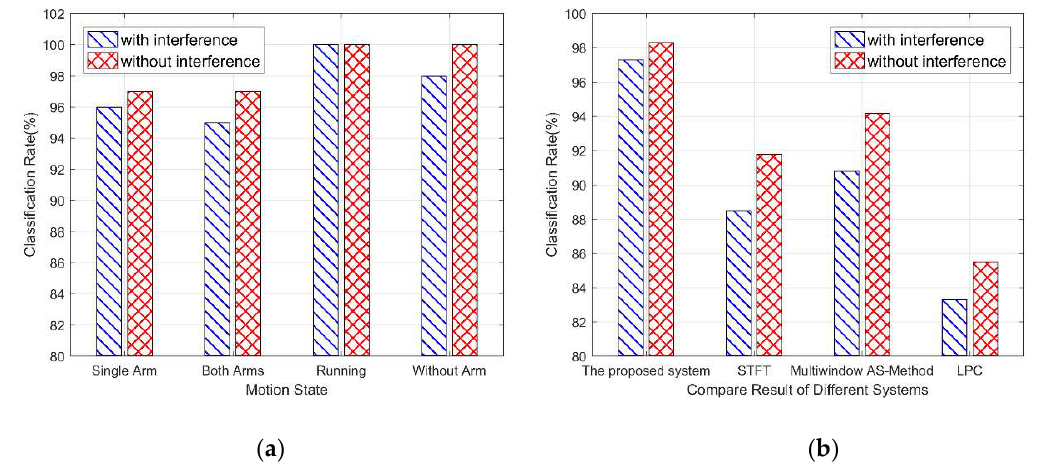
Figure 11. ( a ) Comparison of classification rate of the proposed system with or without interference; ( b ) comparison of classification rate of different systems with or without interference.